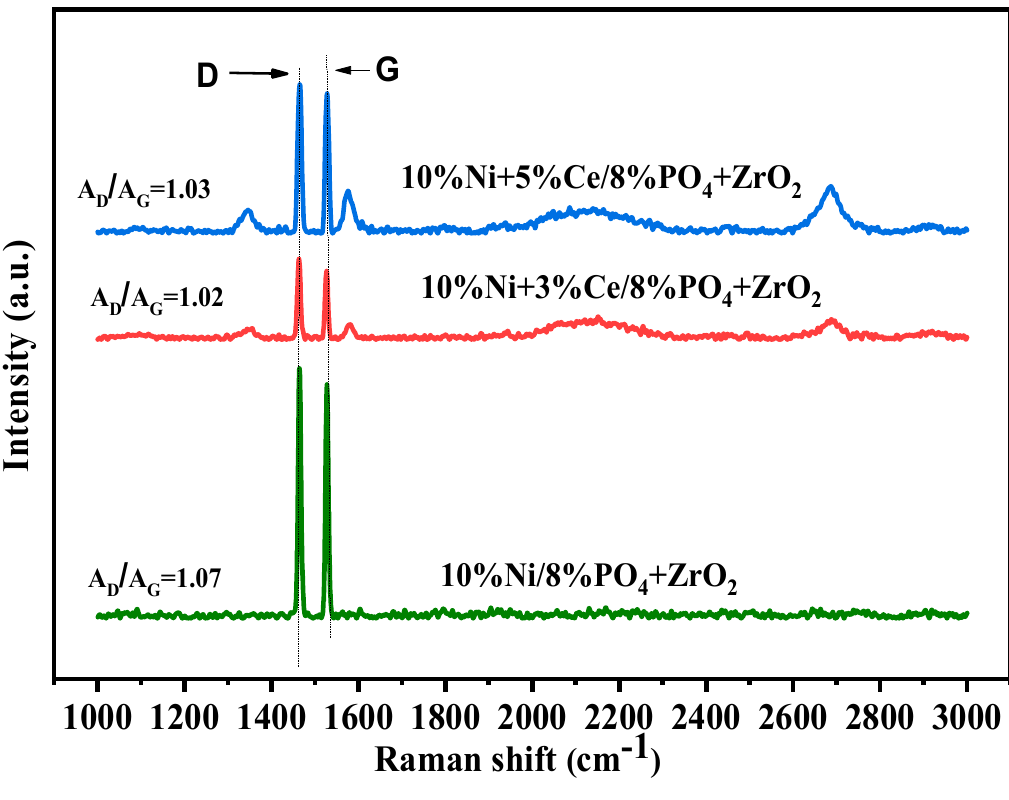
Figure 7. Raman spectra of used catalysts of 10 Ni + x% Ce / 8% PO 4 + ZO 2 (x = 0, 3, and 5) catalyst calcined at 600 ° C, operated at 800 ° C, GHSV = 28000 (ml/g/h).